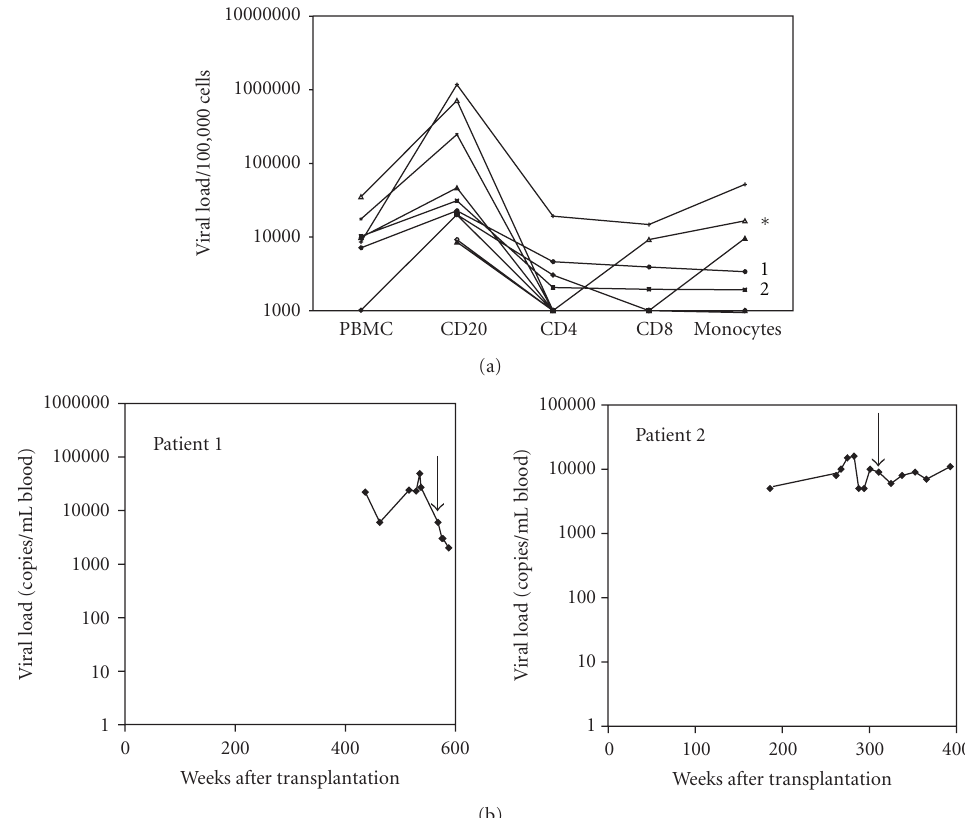
Figure 4: (a) Localisation of EBV DNA in PBMCs of 8 SOT patients sorted into B cells, T cells, and monocytes. As control PBMCs of a patient with NK/T lymphoma was used, indicated with an asterix. PBMCs were sorted by FACS in monocytes and B and T cells. Viral load was determined in 10e5 sorted cells. The purity of the sorted cells was higher than 85%. (b) EBV DNA load in follow-up samples of SOT patients. The arrow indicates the time point of sampling for the analysis of the viral load in the B cells, T cells, and monocytes.